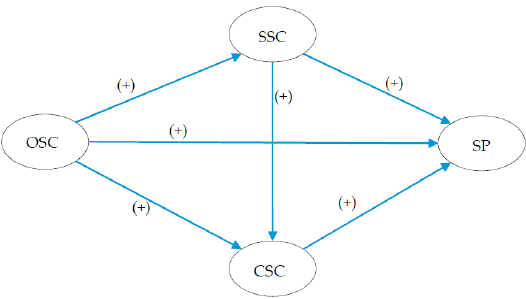
Figure 1. Research model and hypotheses. OSC: organizational safety climate, SSC: supervisor safety